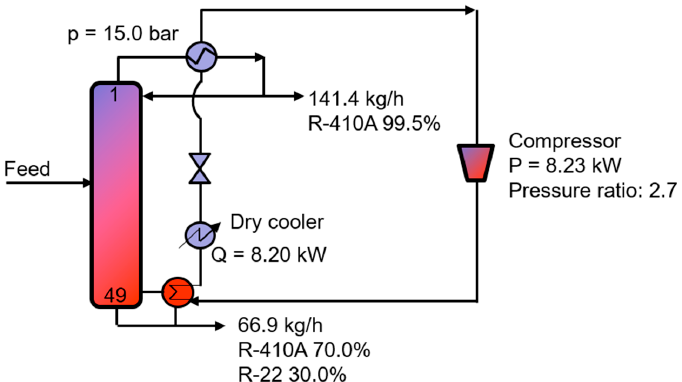
Figure 5. Simplified flowchart illustrating the VC heat-pump-assisted conventional column.